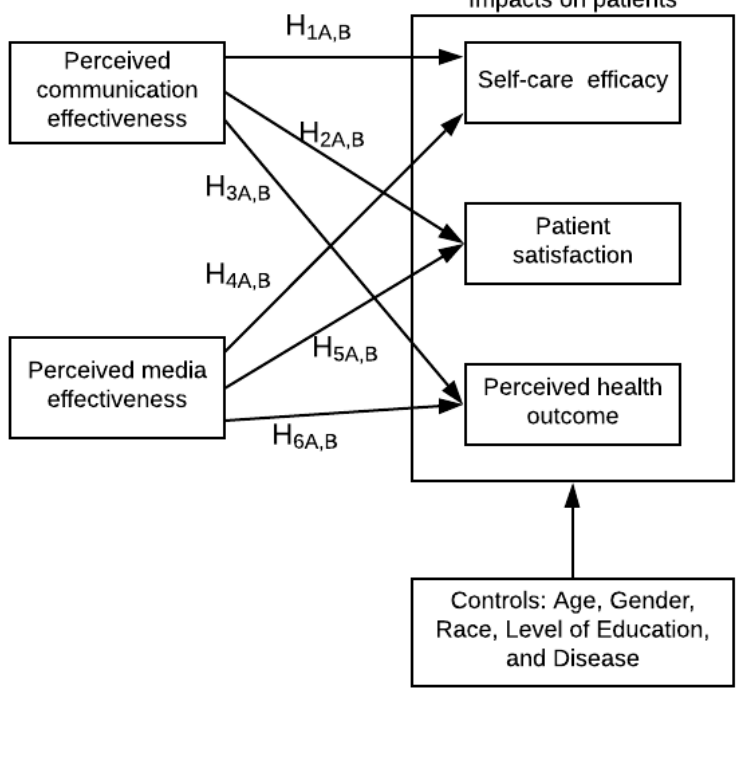
Figure 1. Effective communication comparison (face-to-face communication vs text-based information technology–mediated